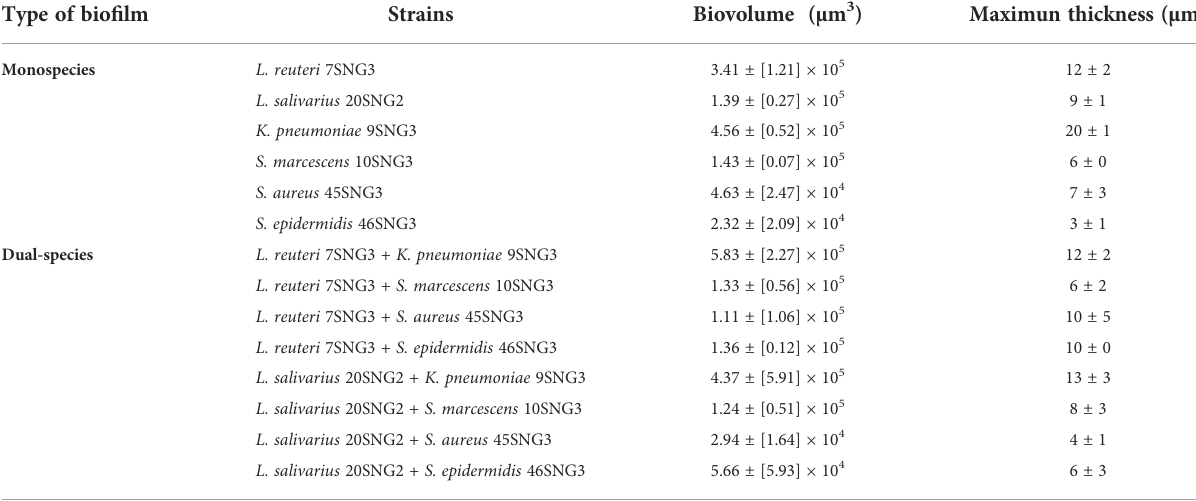
TABLE 1 Biovolume (µm 3 ) and maximum thickness (µm) of monospecies and dual-species bio fi lms of the microbial strains combinations used in this work.